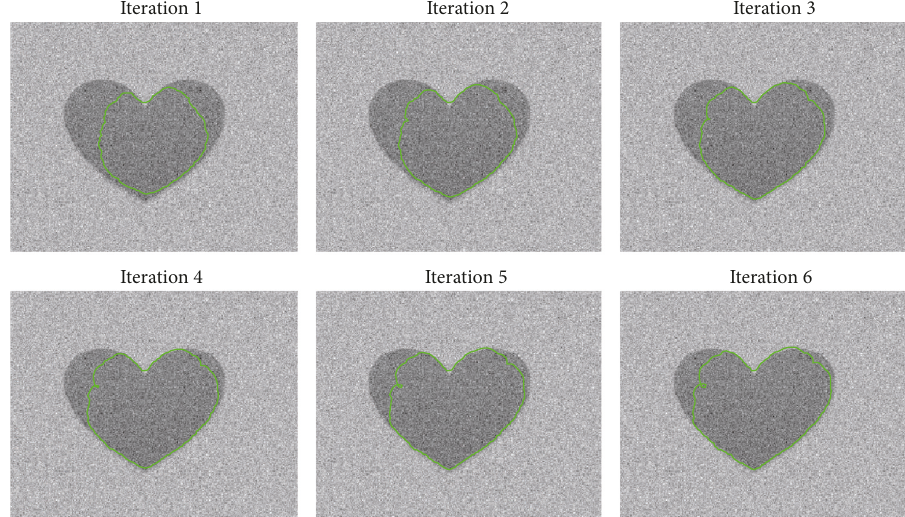
Figure 1: Contour evolves within few iterations; self-crossing of contour appears, which could make the contour suffer from undesired